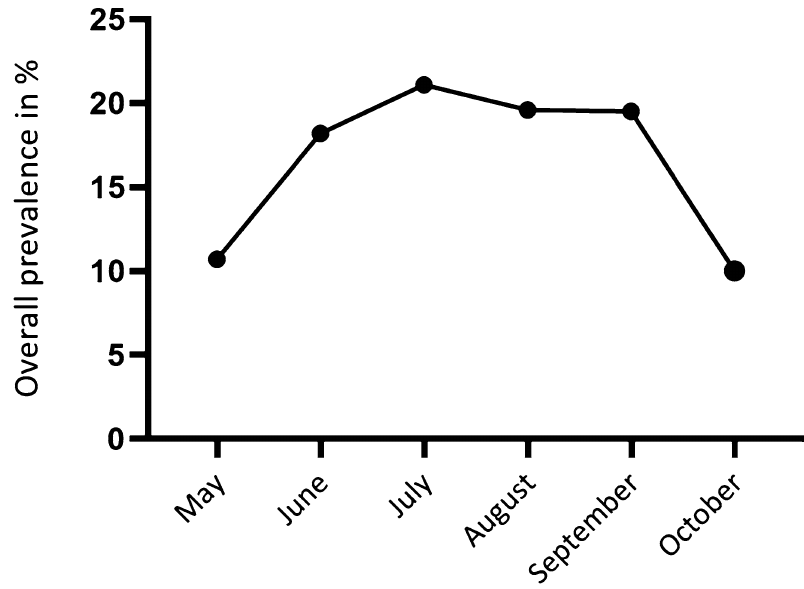
Figure 2. Seasonal overall trematode prevalence pooled from all collected snails in 2017 and